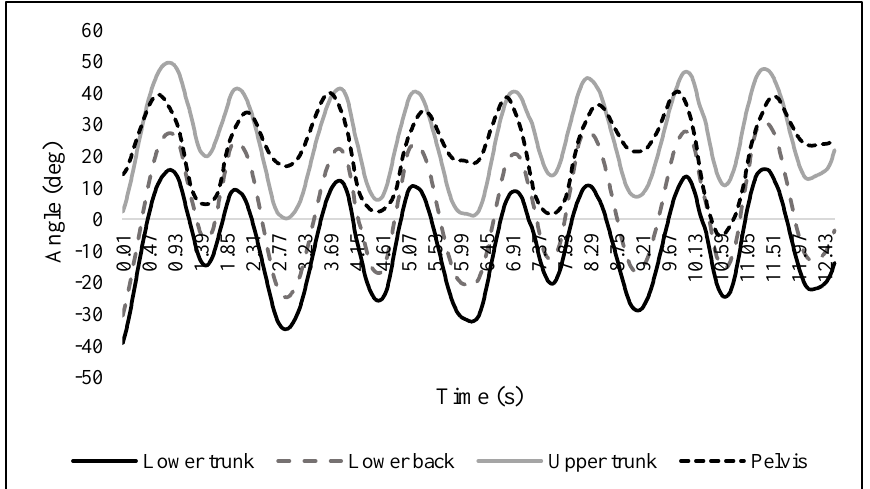
Figure 2. UT, LT, LB, and pelvis kinematics during repetitive sit-to-stand and stand-to-sit calculated using the method described by Needham et al. (2014) [32].